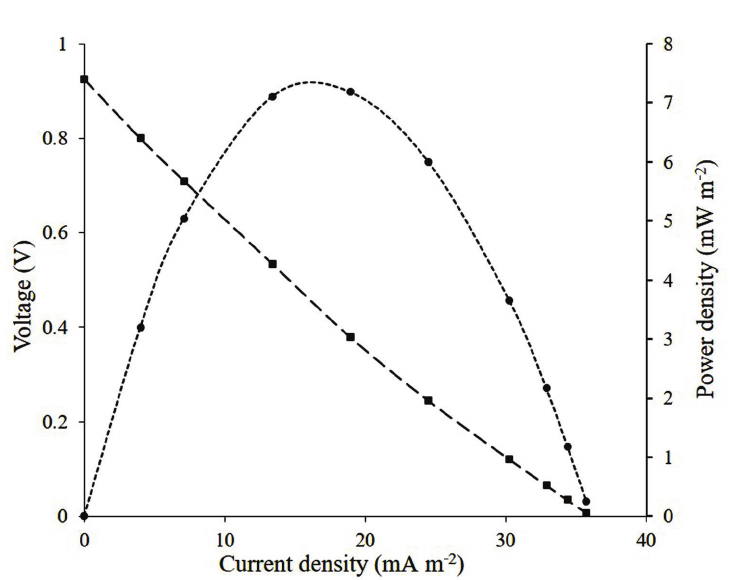
Fig. 8 – Polarization and power density curve of the CW-MFC